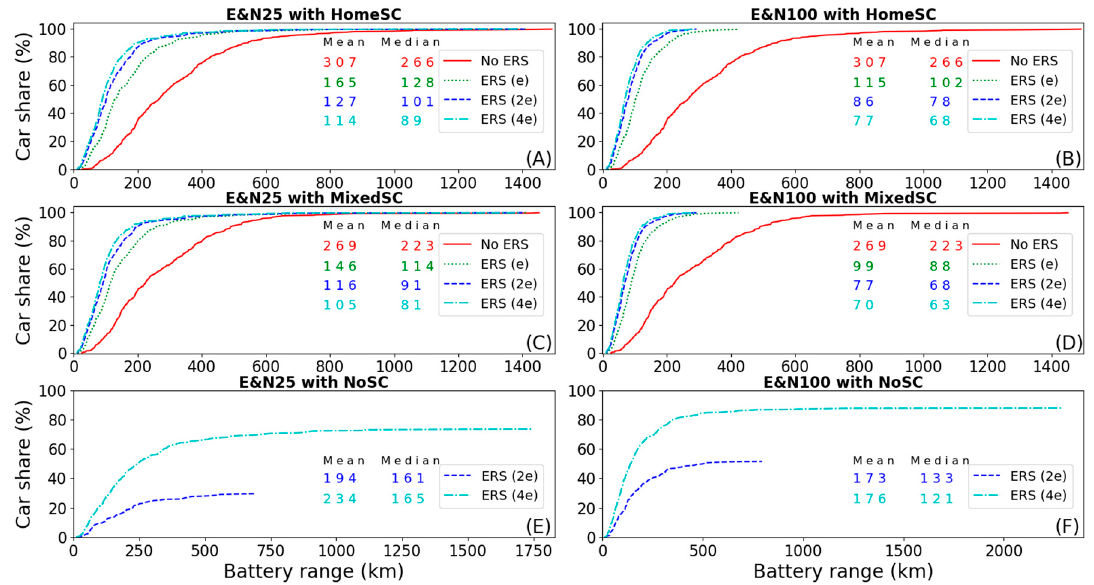
Figure 4. Cumulative share of cars for required battery ranges to cover all driving in the 25% of E and N roads (E and N25) case (left) and 100% of E and N roads (E and N100) case (right). The numbers next to the legend boxes are the mean and median battery ranges required to meet all driving. Note that ( E , F ) have different scales for x-axis than ( A – D ). HomeSC: home-only stationary charging,